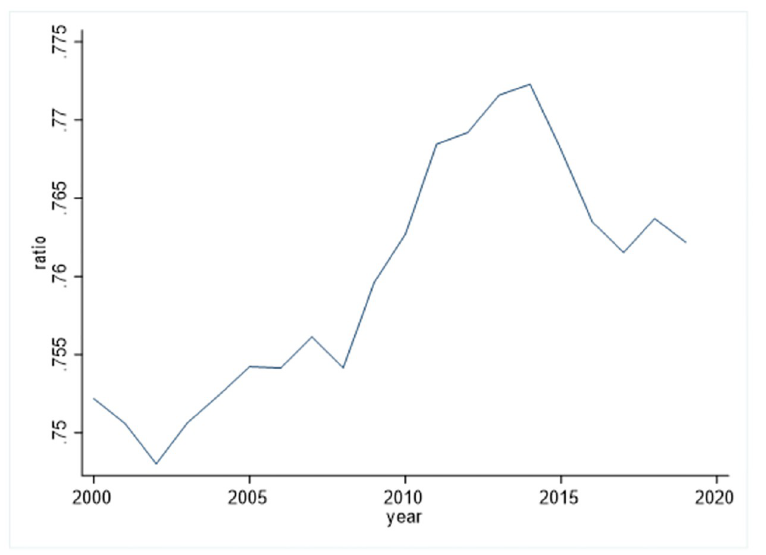
Fig 1. The ratio of G20 countries’ total CO2 emissions to the